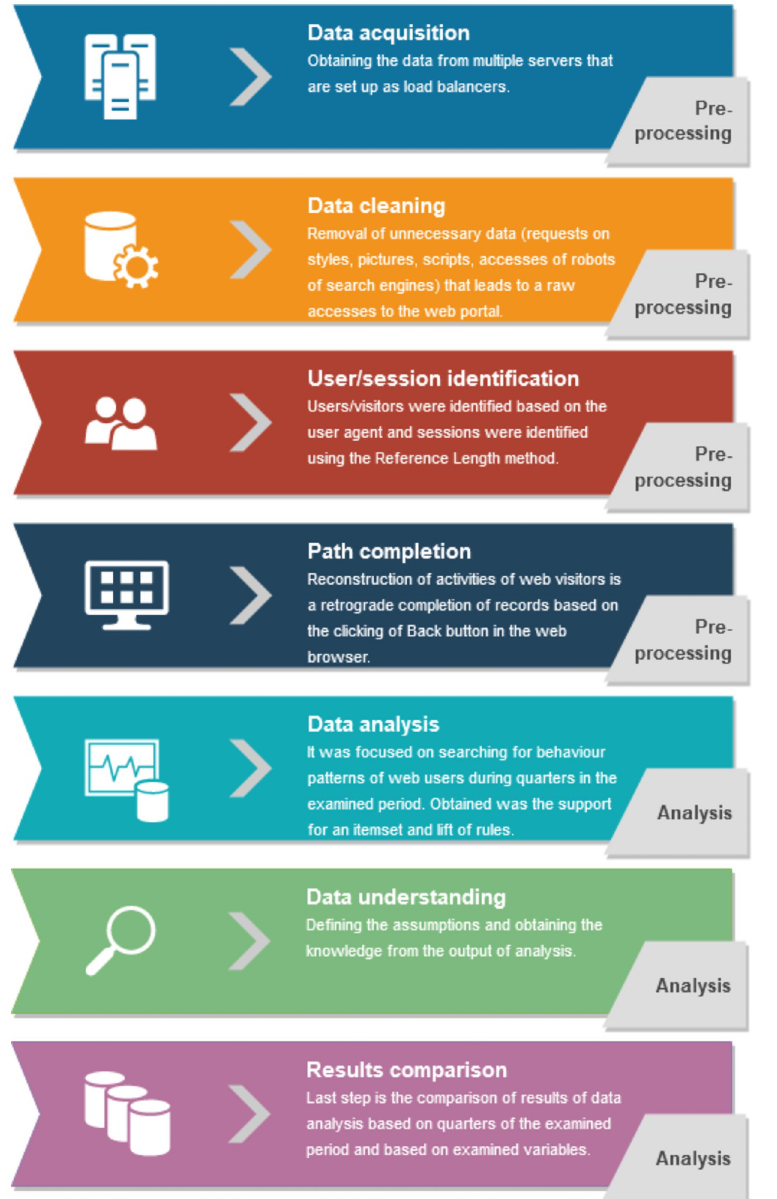
Fig 1. The approach used to process the log